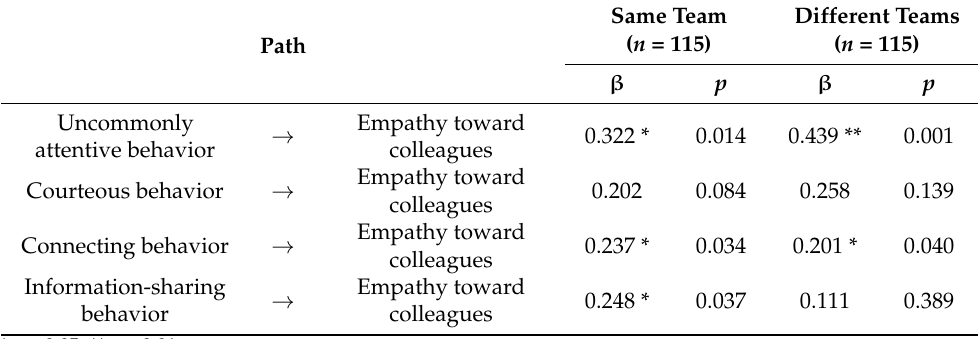
Table 10. Effects of rapport-building behaviors on empathy toward colleagues moderated by the presence of participant’s closest colleague within the same team.